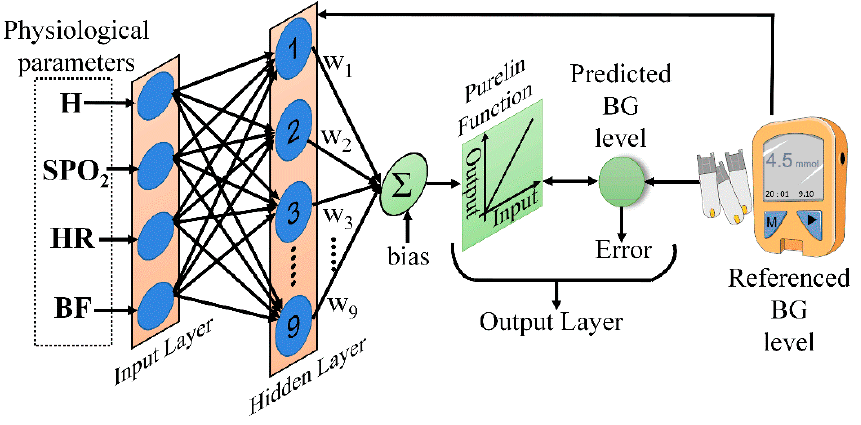
Figure 6. The BPNN model used for prediction.